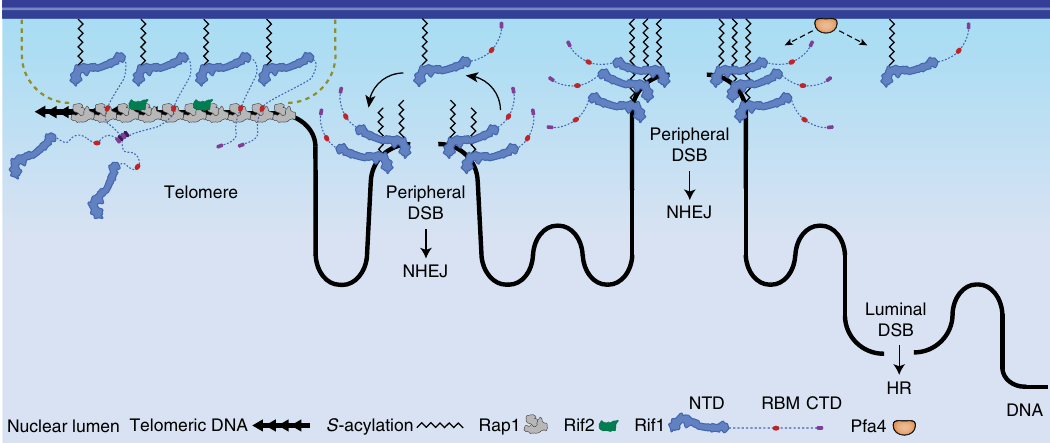
Fig. 7 Rif1 S -acylation mediates nuclear-peripheral DSB repair pathway choice. Pfa4-dependent S- acylation of Rif1 provides membrane anchors and governs localization of Rif1 to the inner nuclear membrane. Telomeres are tethered to the nuclear envelope by Rif1-independent mechanisms (dashed lines) and Pfa4 is dispensable for telomere homeostasis. In contrast, Pfa4-dependent Rif1 S- acylation at residues C466 or C473 (depicted as a zig-zag line) is essential for Rif1-mediated NHEJ. We propose that the increased local concentration of S -acylated Rif1 in proximity of the inner nuclear membrane generates a nuclear-peripheral compartment in which Rif1 is effective in promoting DSB repair by